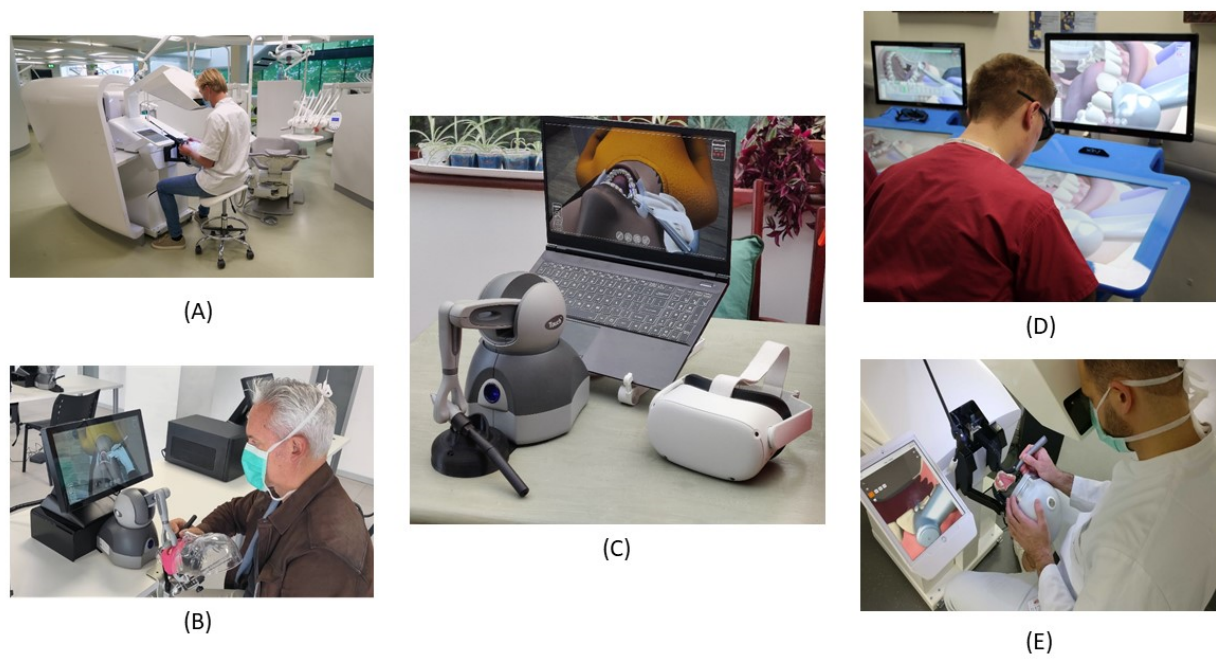
Figure 3. Different type of commercialized simulators in dental education trainings: ( A ) SIMtoCARE, ( B ) Model T- Uni Sim, ( C ) Model L—Uni Sim, ( D ) Virteasy Dental, and ( E ) SIMtoCARE.